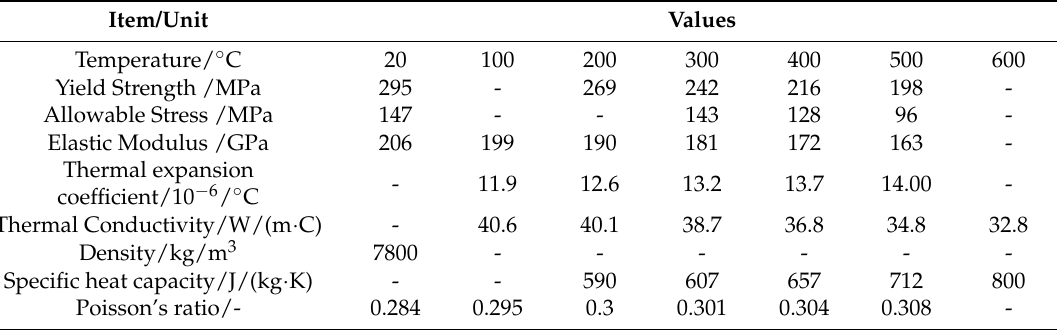
Figure 12. Shear stress contours along the front wall.